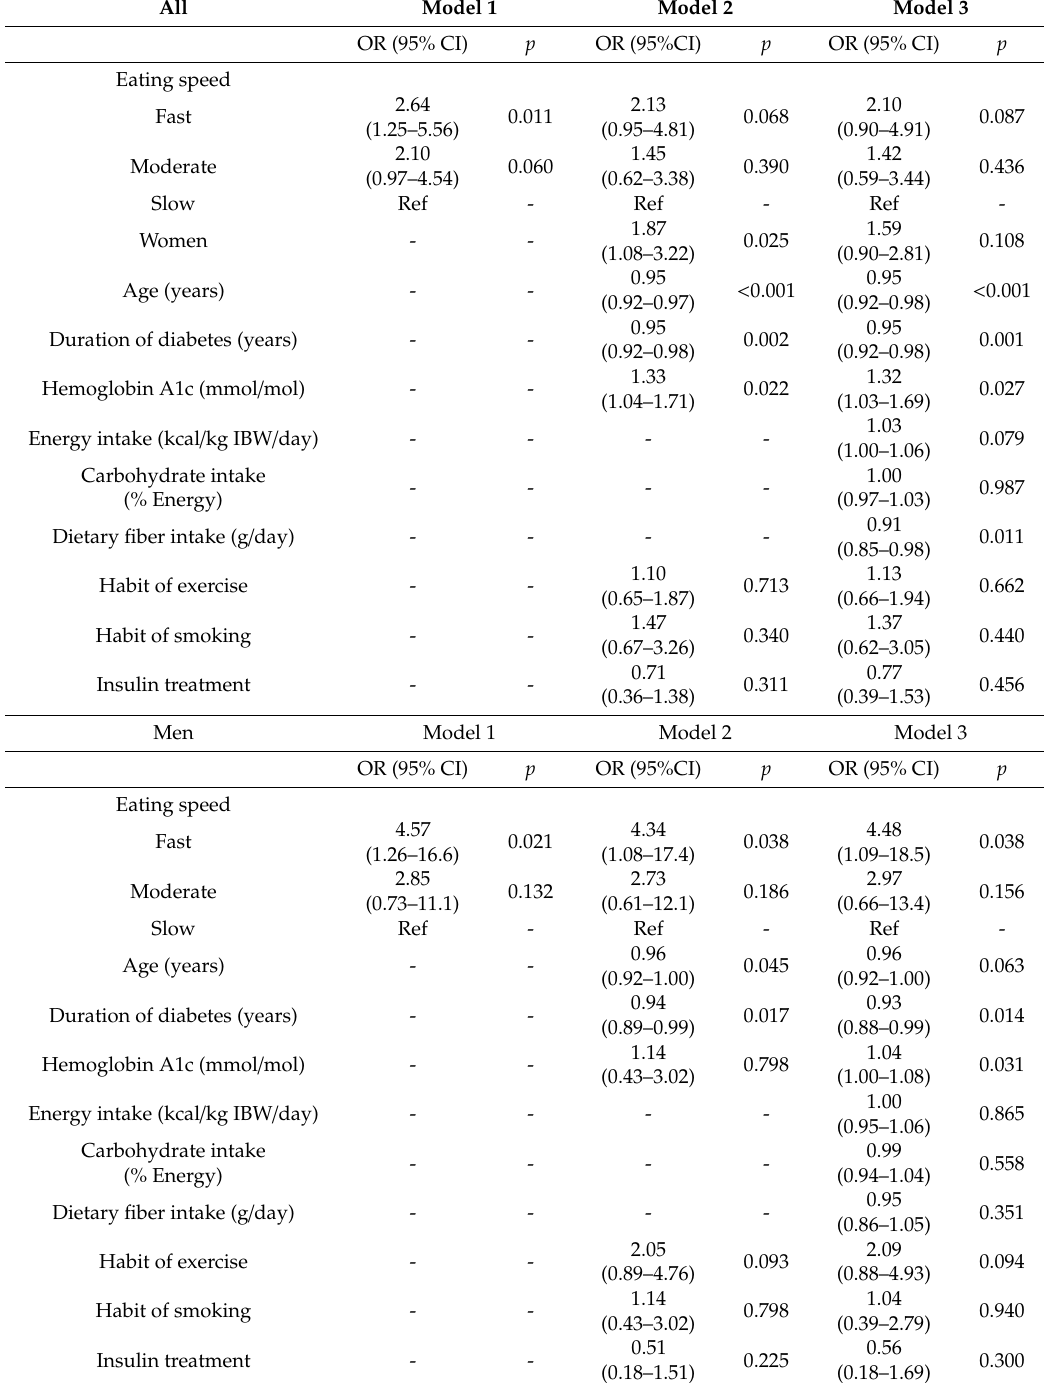
Table 3. Logistic regression analysis on the presence of fatty